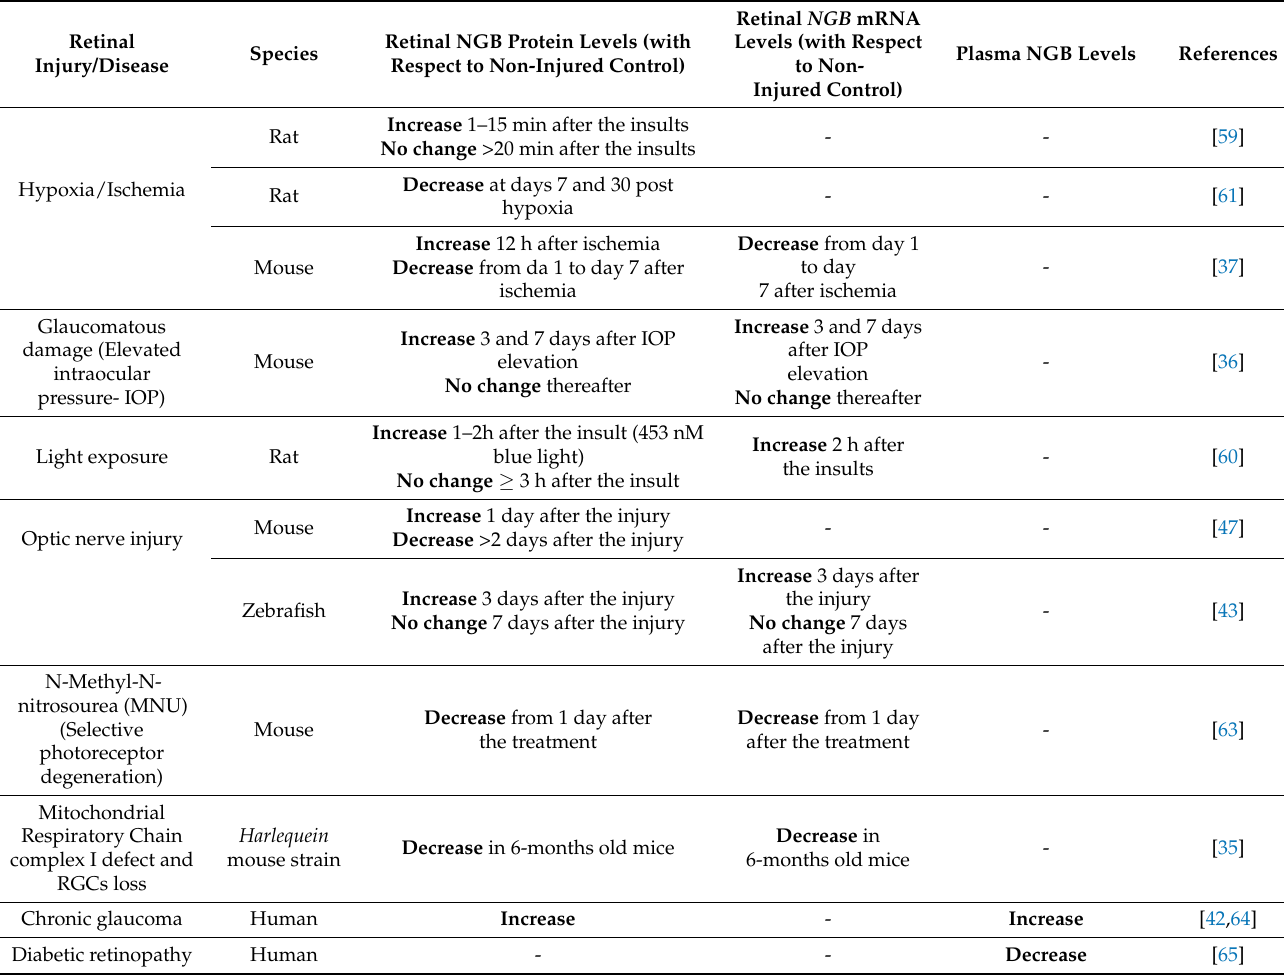
Table 2. Summary of NGB mRNA and protein levels modulation by retinal injuries/disease among different species. Retinal Retinal NGB Protein Levels (with Species Injury/Disease Respect to Non-Injured Control)